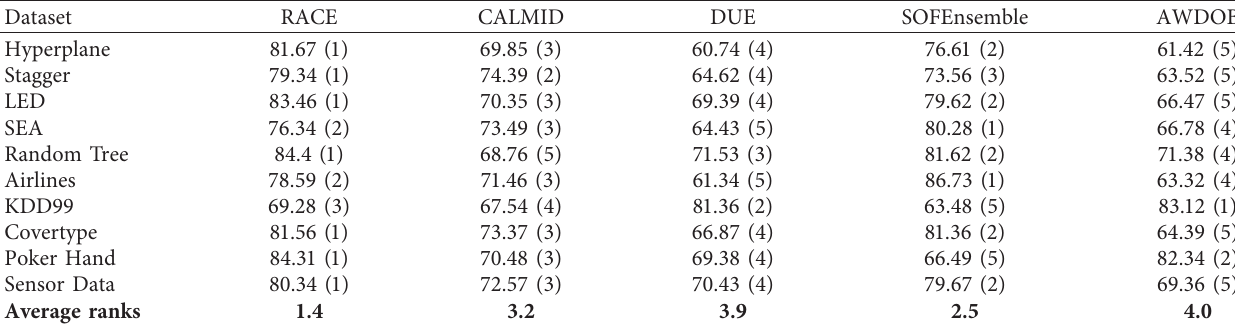
Table 2: Prediction accuracies and average ranks of the five algorithms.